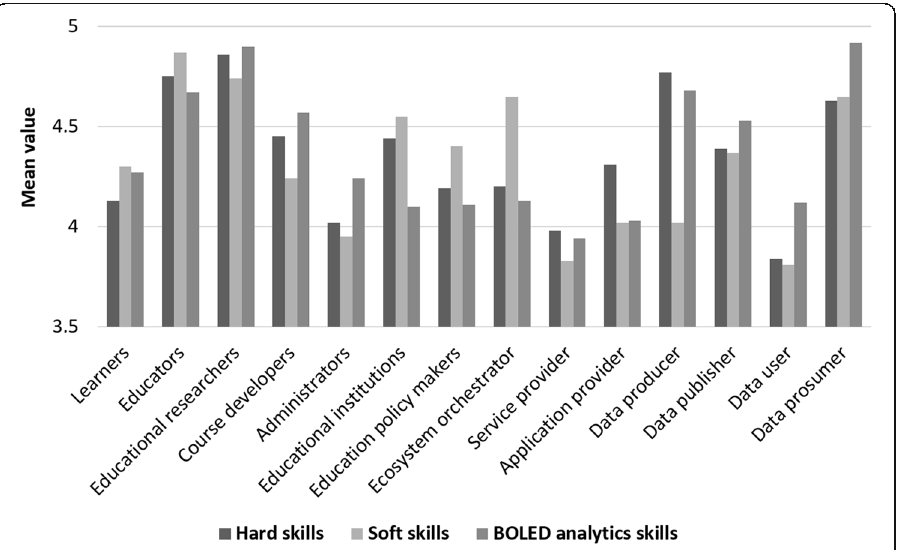
Fig. 8 The mean values for each category of skills provided by the Delphi-based expert opinion